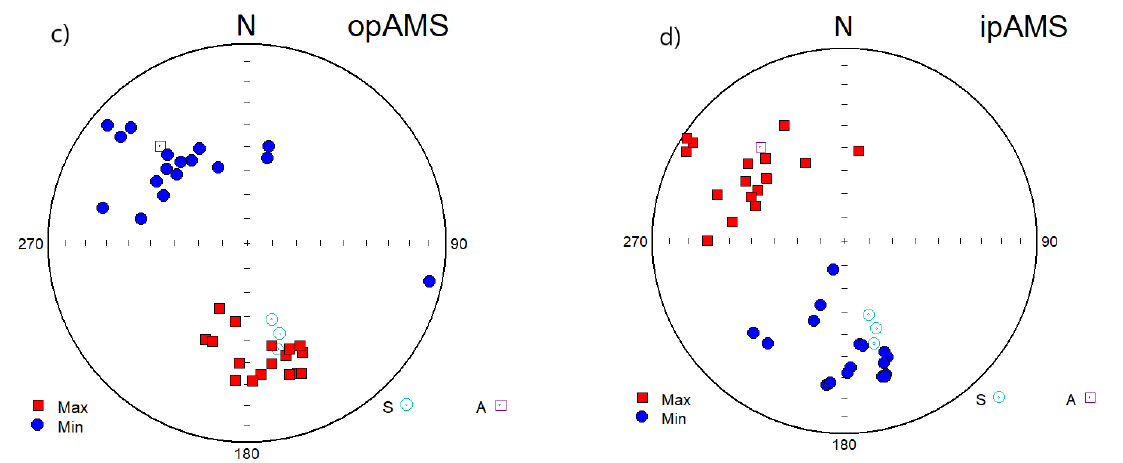
Figure 11. The opAMS and ipAMS fabrics in the locality of M ě stský vrch. ( a ) P - T plot for opAMS, ( b ) P - T plot for ipAMS, ( c ) directional elements for opAMS, ( d ) directional elements for ipAMS. Symbols: Max—magnetic lineation, Min—magnetic foliation pole, S—metamorphic schistosity, A—mesoscopic lineation. Equal area on lower hemisphere. Adapted from [26].